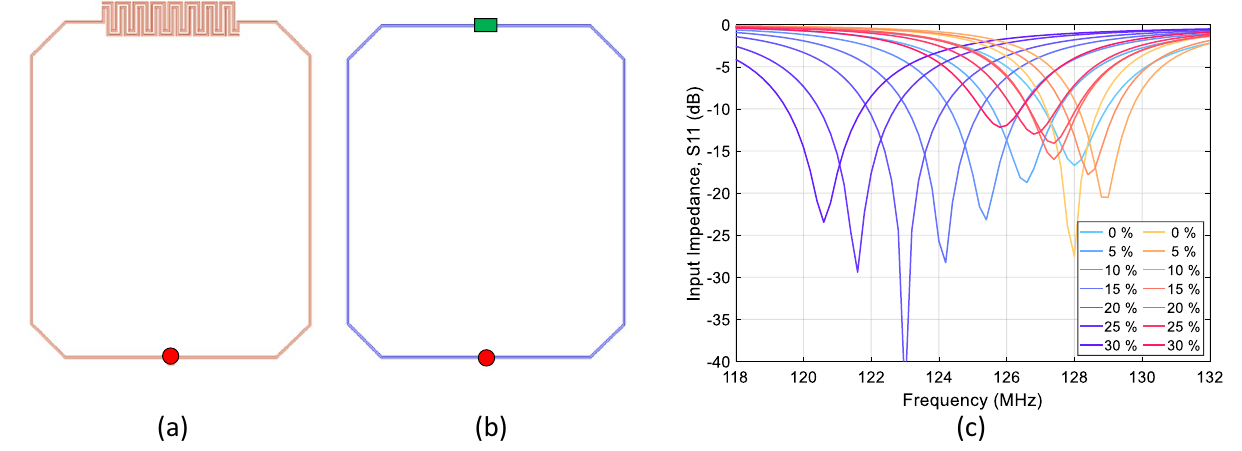
Figure 2. Simulation models of the ( a ) proposed coil with stretchable interdigital capacitor and ( b ) control coil with fixed value capacitor (green rectangle). ( c ) Simulated input impedance (S 11 ) change with stretch for the proposed (red) and control (blue) coils showing frequency stability of the proposed